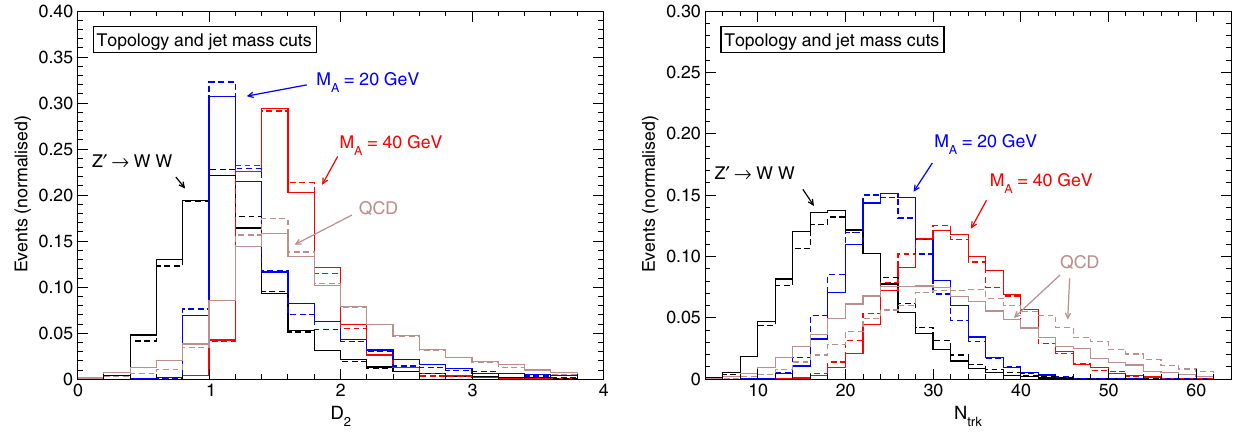
Fig. 6 D 2 variable (left) and number of tracks (right) for R → SS and Z (cid:8) → WW signals and the QCD dijet background. Solid (dashed) lines correspond to the leading (subleading) jet For Z (cid:8) → W W and the background the distributions are sim- ilar to the ones obtained by the ATLAS Collaboration [38], slightly shifted to smaller D 2 values. For R → SS the distri- butions are background-like, especially for M A = 40 GeV.